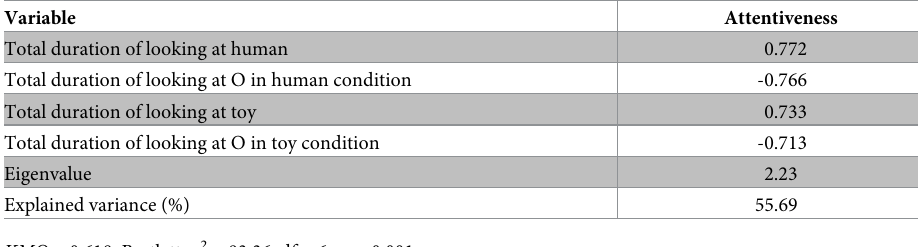
Table 10. Component derived from PCA on the variables measured in the attention subtest.